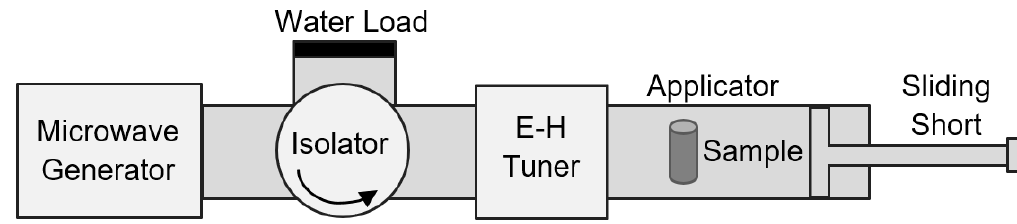
Figure 1. Schematic view of the microwave (MW) set-up. The sample is placed at the center of the waveguide where the electric field is maximum.